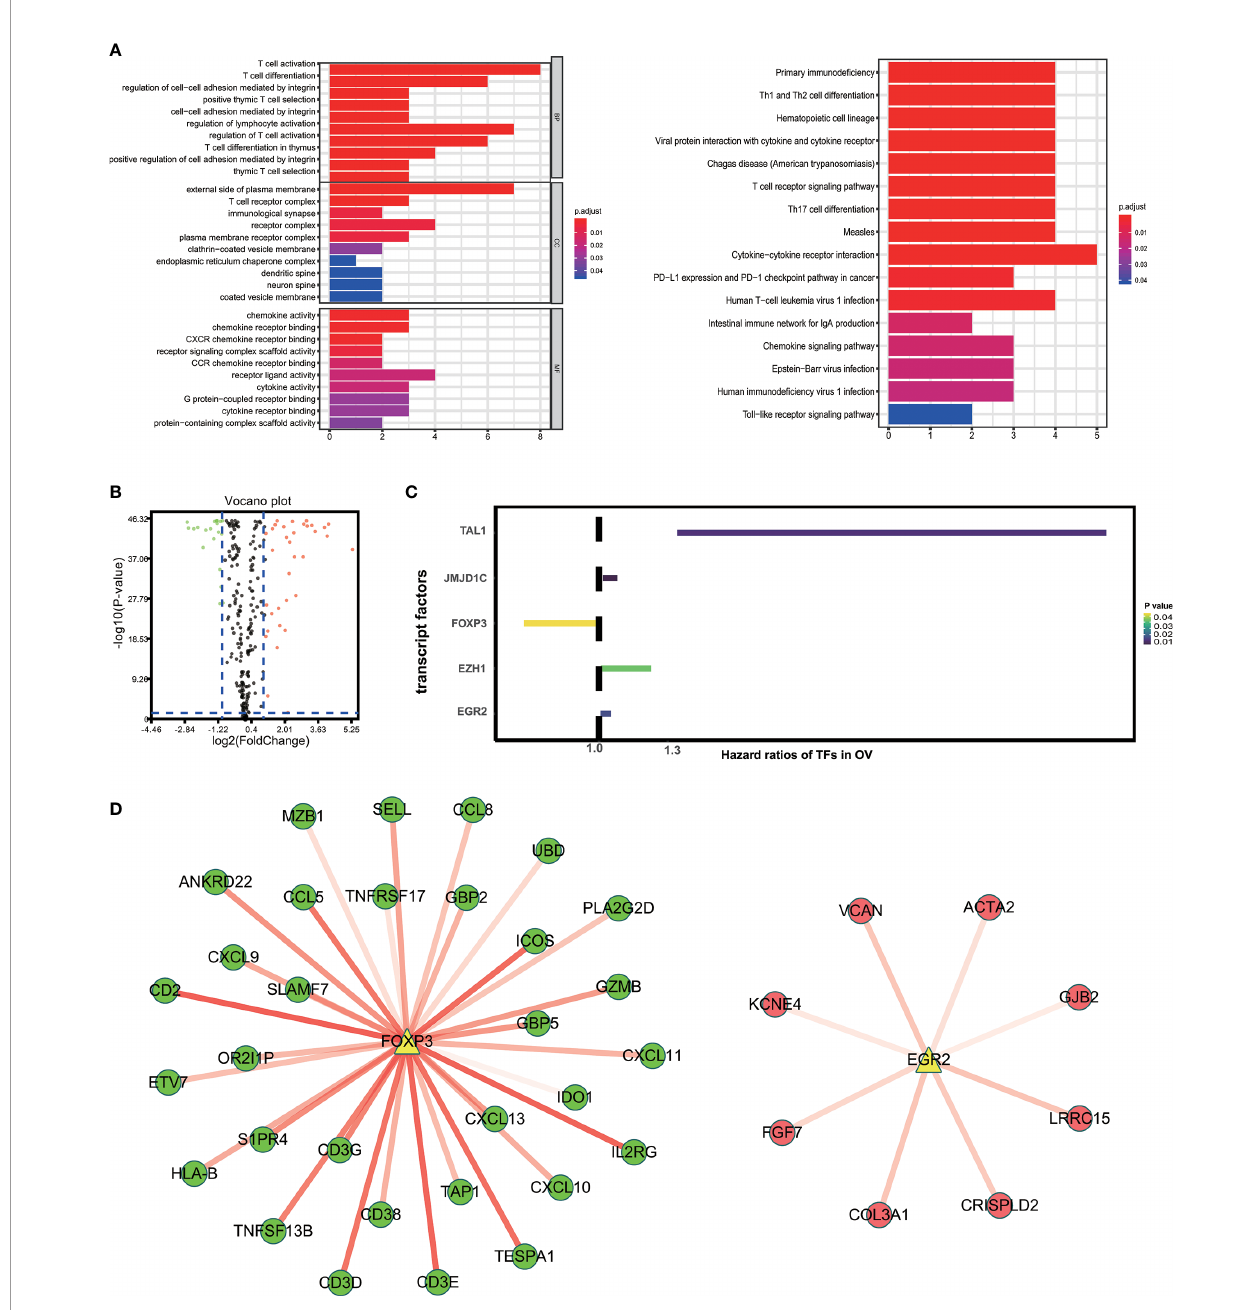
FIGURE 3 | Characteristics of 59 immune-related prognostic genes. (A) Top GO terms and KEGG pathways enriched by IRPG. (B) Volcano plots reveal differentially expressed transcript factors (TFs) between tumor and adjacent tissues. (C) The Hazard ratios of identi fi ed TFs with prognostic value. (D) TF-based regulatory